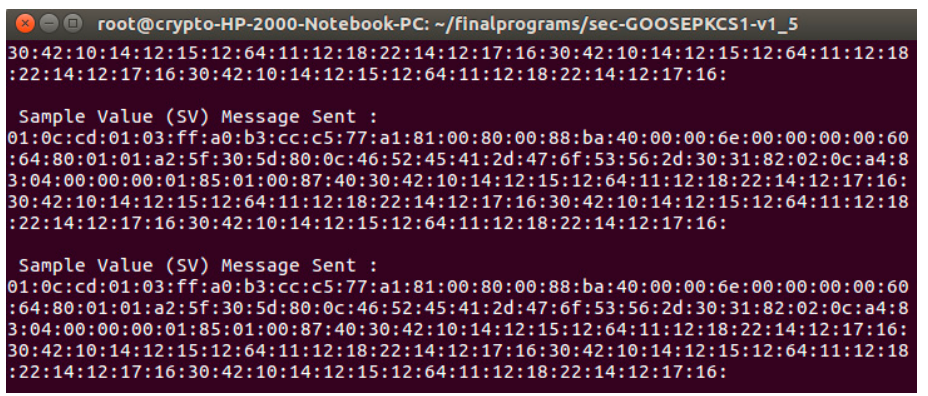
Figure 12. Infotech Avenue Receiver detecting the stream of GoSV software framework.